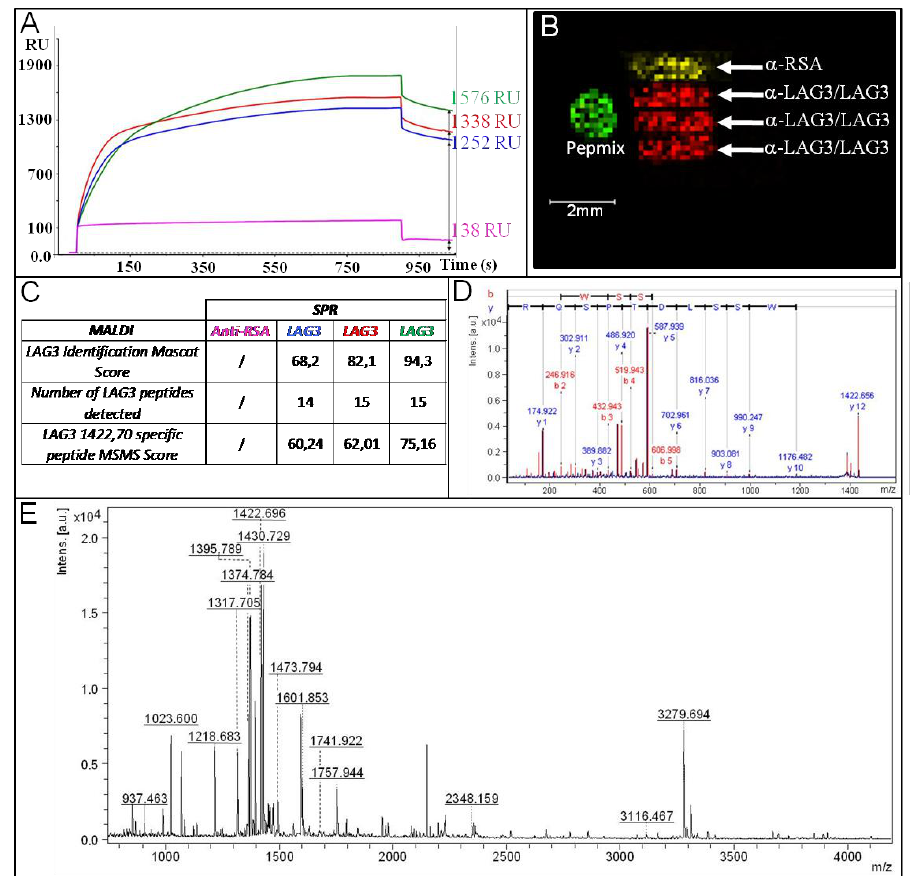
Figure 6. ( A ) Sensorgram of LAG3 capture in diluted total human plasma (2.5%) on α-LAG3 (in green, red and blue) and α-RSA (in pink). ( B ) On-chip MALDI-MS image showing the distribution of the specific peptides from LAG3 ( m/z 1,422.69) in red, α-RSA ( m/z 1,697.20) in yellow and calibration sample (Pepmix, m/z 1,296.68) in green. ( C ) Results of on-chip MALDI-MS and MS/MS analysis. ( D ) MS/MS spectrum obtained for the peak m/z 1,422.69. ( E ) On-chip MALDI-MS spectrum of LAG3 after in situ tryptic